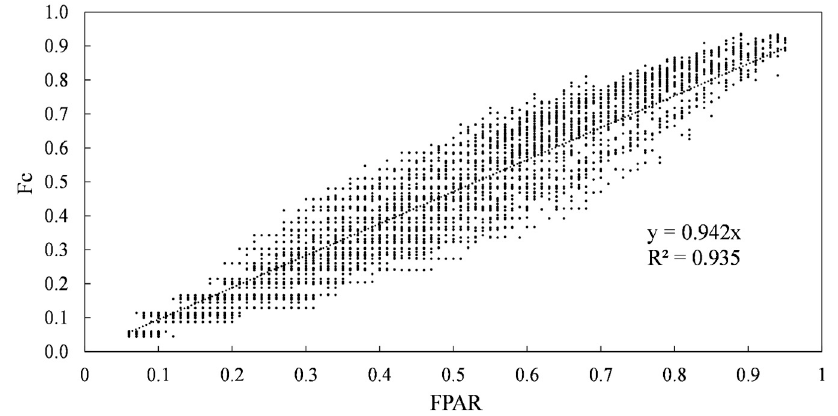
Figure 7. Comparison between LAI derived F c values determined using Equation (5) and FPAR values of a selected MCD15A2 tile (h10v05).